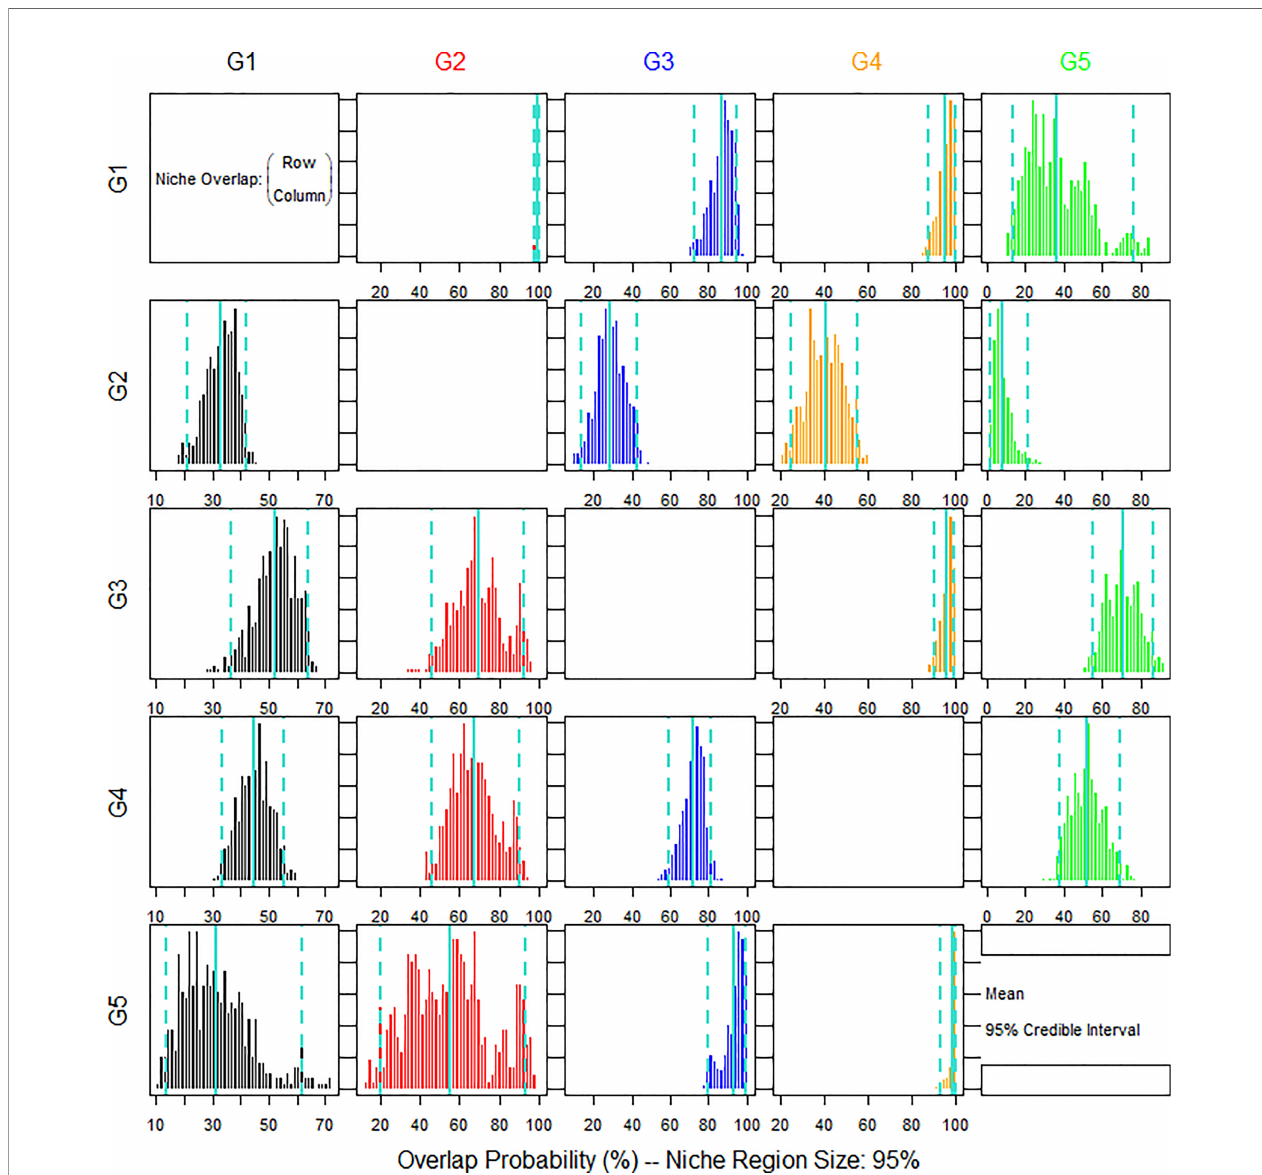
FIGURE 5 | Bayesian plot of the posterior probability distribution of niche region metric (%) for fi ve species of sciaenid fi sh collected from the Zhoushan Archipelago between 2019 and 2021 estimated by nicheROVER analysis. The posterior means and 95% credible intervals are displayed in turquoise